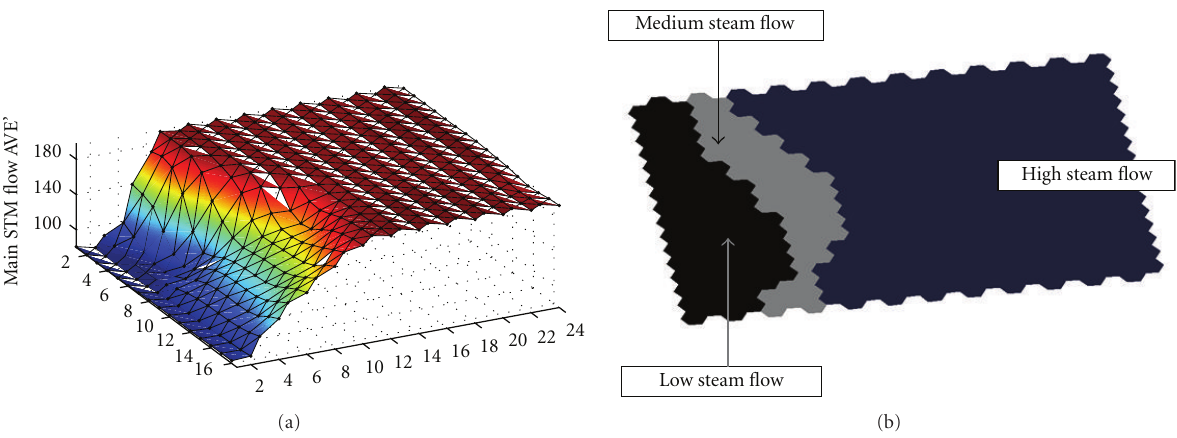
Figure 4: (a) The behavior of the main steam flow on a 24 ∗ 16 SOM and (b) a clustered SOM ( k = 3), which shows the separation of process states into three locations on the SOM.